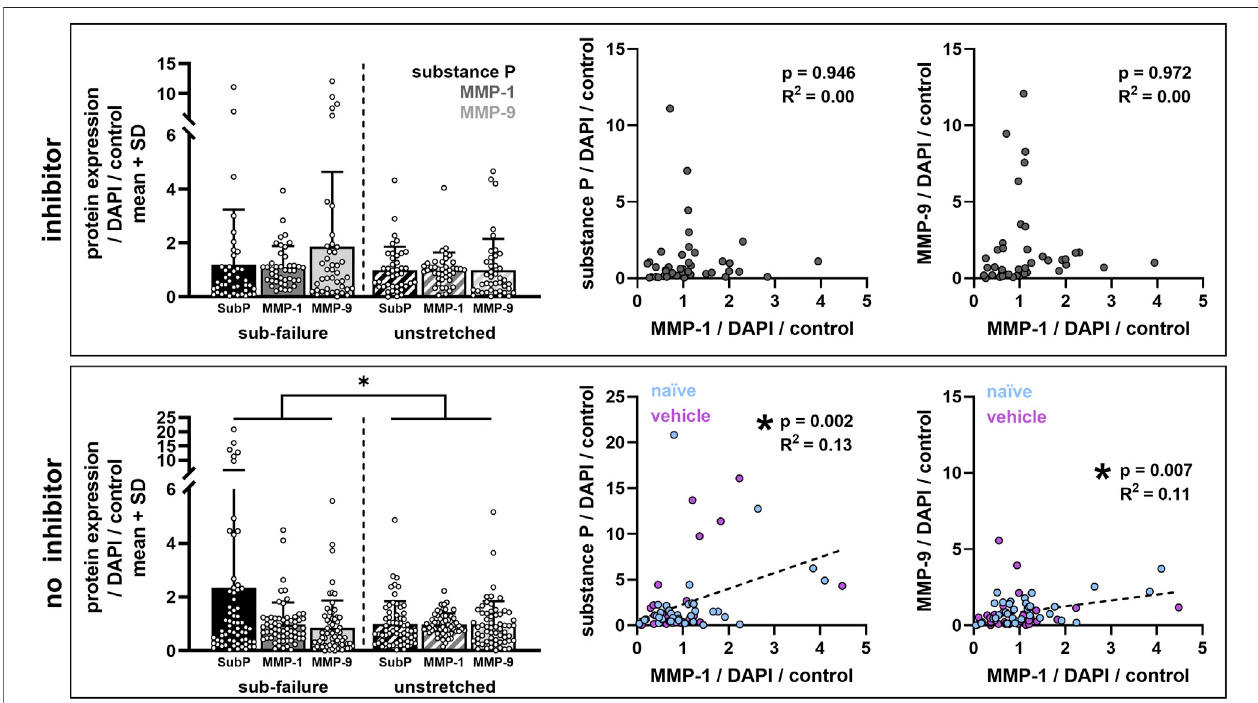
FIGURE8| Ilomastattreatmentpreventsstretch-inducedincreasesinsubstancePandabolishesthecorrelationsbetweenMMP-1andsubstancePandbetween MMPs with each other. Bar plots show protein expression data grouped by co-cultures that did (inhibitor) or did not (no inhibitor) receive ilomastat pre-treatment. Sub-failure stretch signi fi cantly effects protein expression outcomes (no inhibitor: * p = 0.038; MANOVA) only in the absence of an inhibitor (inhibitor: p = 0.114; MANOVA). Scatter plots show linear regressions between expression levels of different proteins (left: MMP-1 vs. substance P; right: MMP-1 versus MMP-9) with each data point representing labeling in a single confocal image. Signi fi cant correlations are detected between MMP-1 and substance P ( p = 0.002; R 2 = 0.13) and between MMP-1 and MMP-9 ( p = 0.007; R 2 =0.11) in co-cultures without an inhibitor (naïve and vehicle; n =11 gels). Correlationsare not signi fi cantwithinhibitor ( n =7